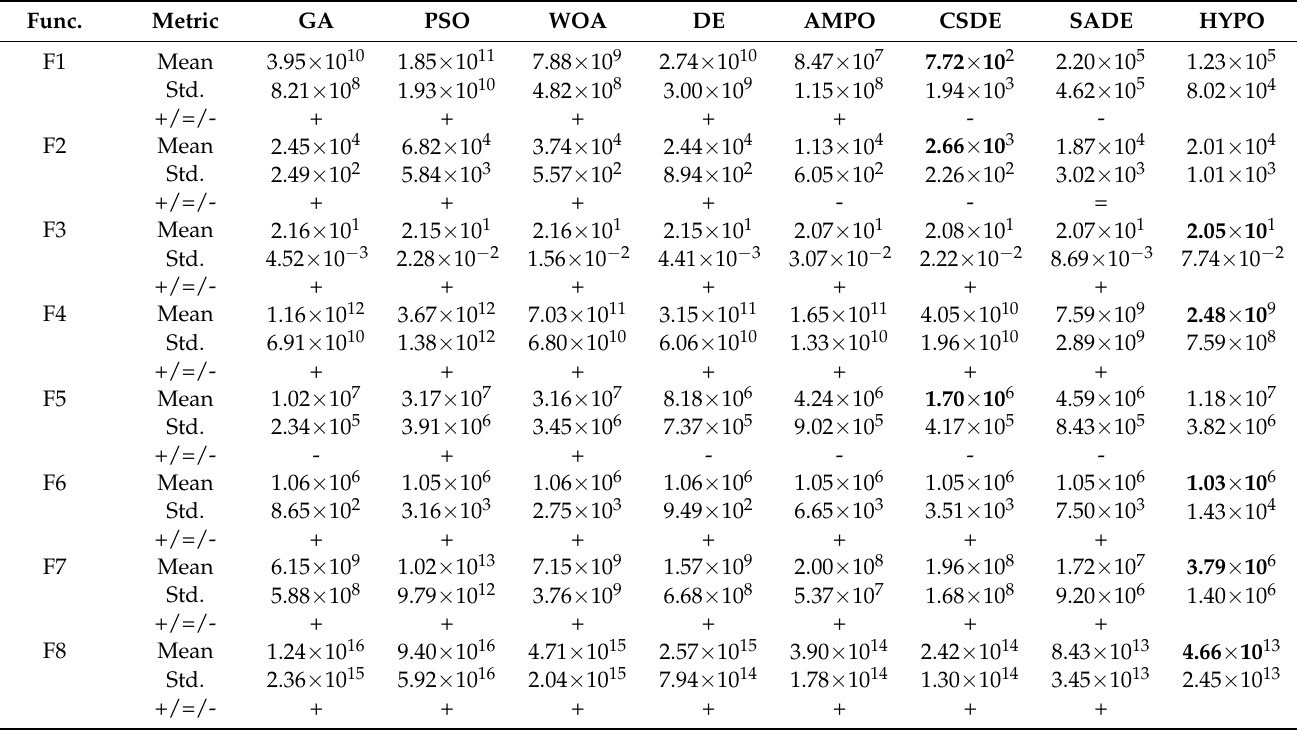
Table 2. Comparative Results on the CEC2019